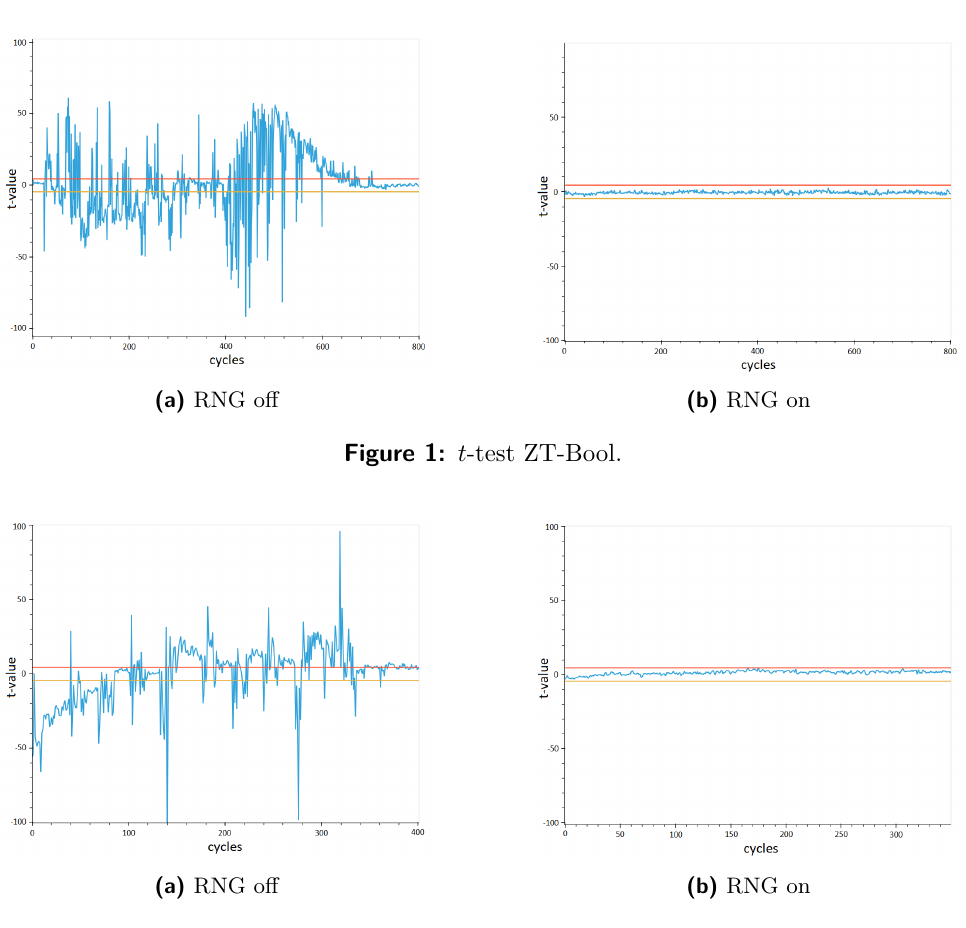
Figure 2: t -test